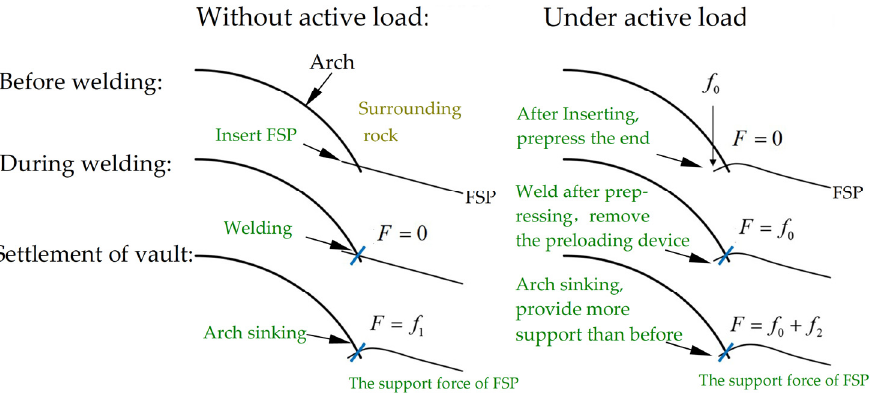
Figure 10. Schematic diagram of nonactive and active bearing process of FSP.